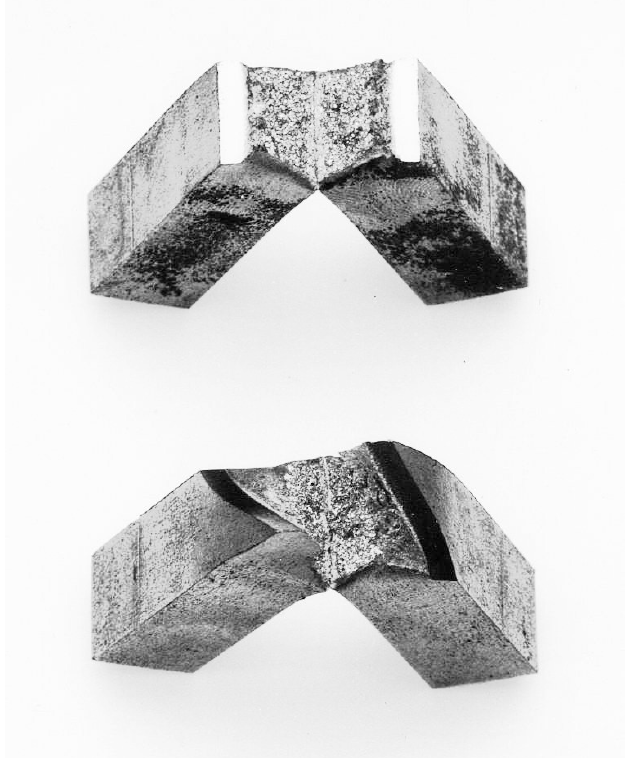
Figure 12. Fracture appearance of mild steel Charpy specimens tested at 10 C. Top, standard specimen, β = 90 ° . Bottom, angle notch specimen, β = 45 ° .